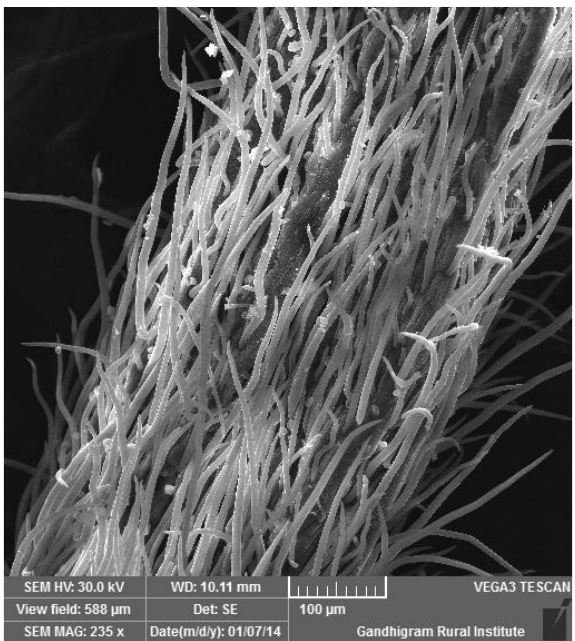
Image 1h. SEM image of style: closer view